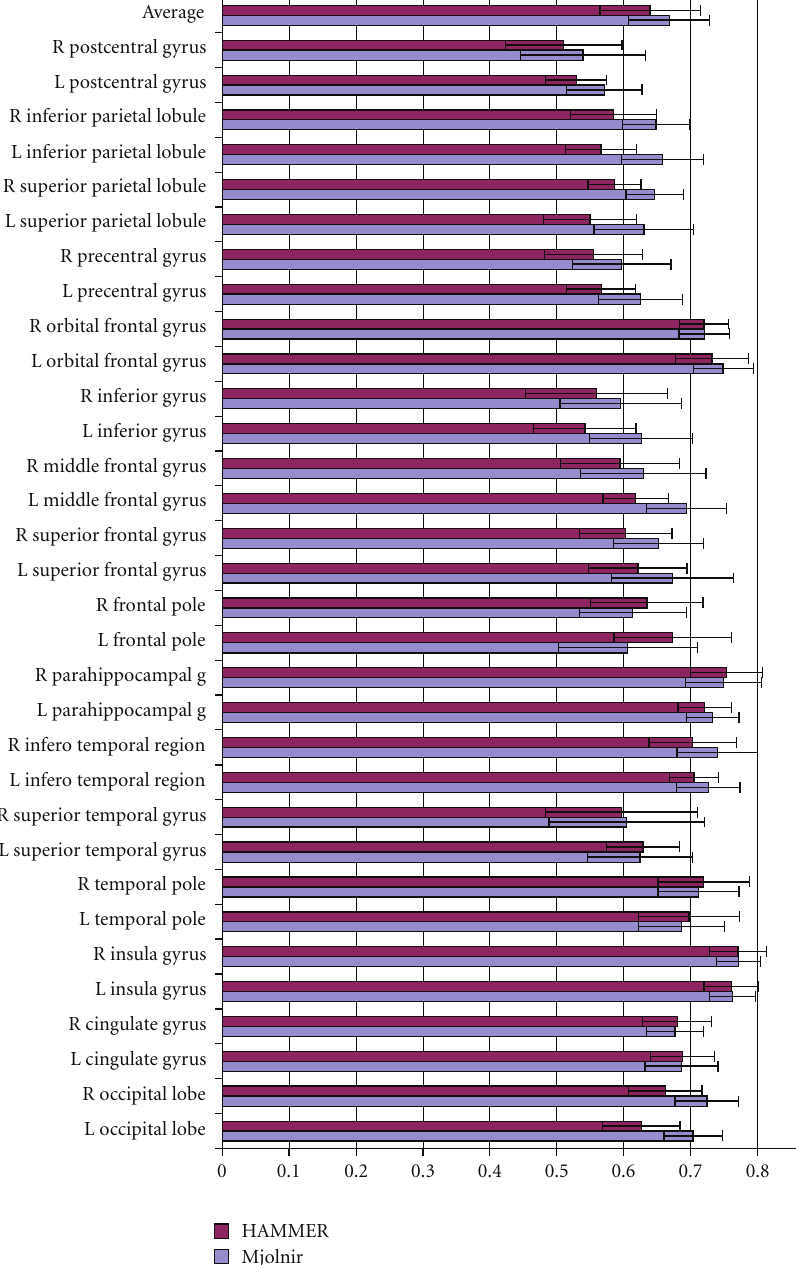
Figure 11: Average Dice coe ffi cient for di ff erent anatomical regions on the left and right hemisphere (labeled L and R) for HAMMER and Mjolnir when registering 16 randomly selected image pairs. The top set of bars shows the average over all regions, and the error bars represent the standard